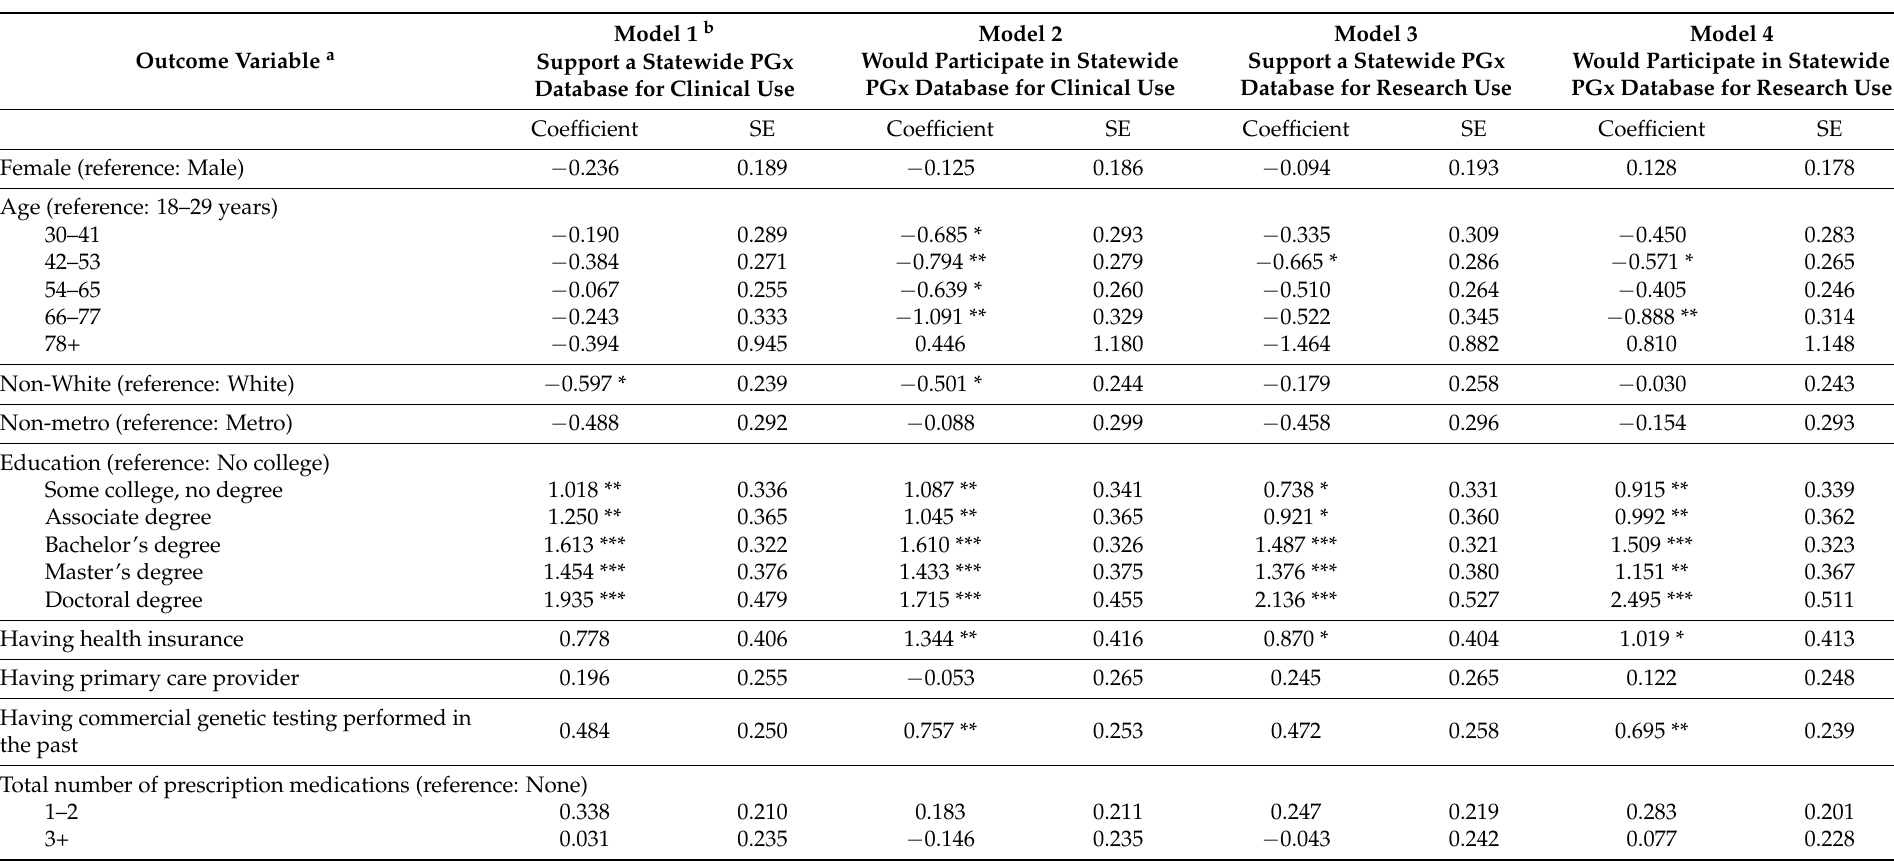
Table 3. Multivariable logistic regression models of the acceptability of a statewide pharmacogenomic database on sociodemographic and health-related